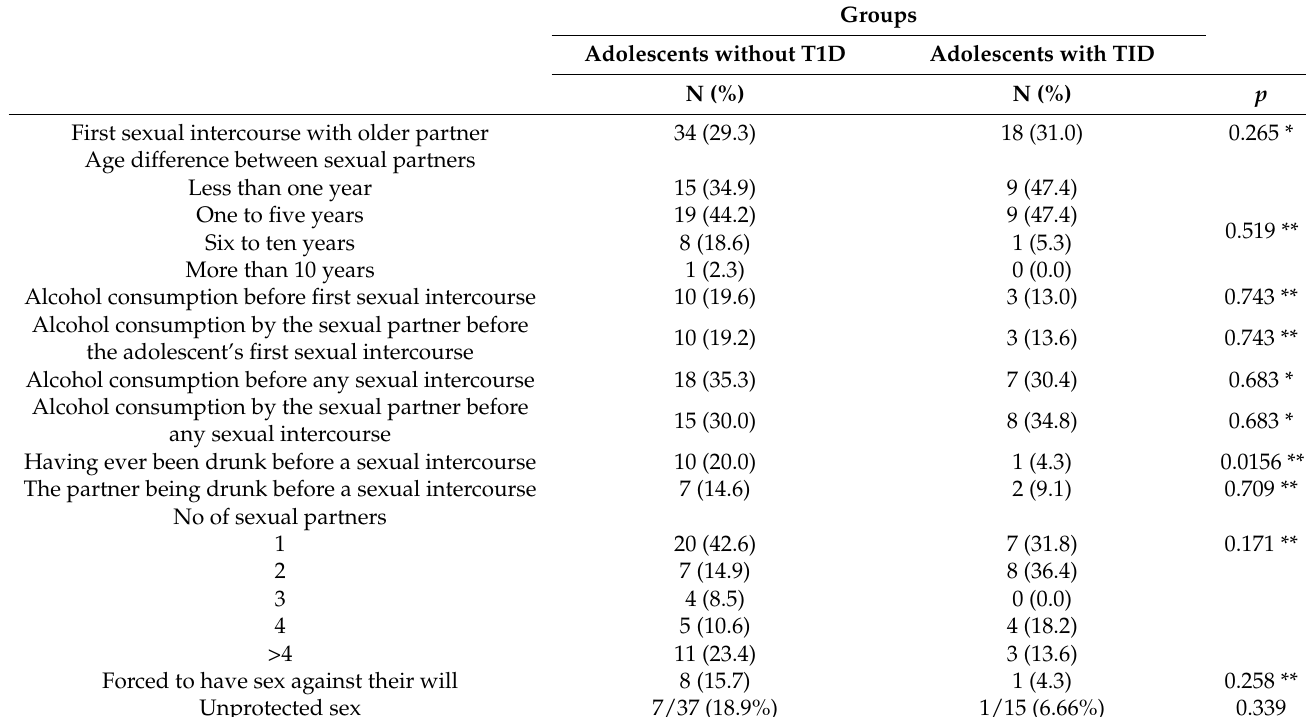
Table 2. Risky behaviors in sexually active adolescents for the two groups.